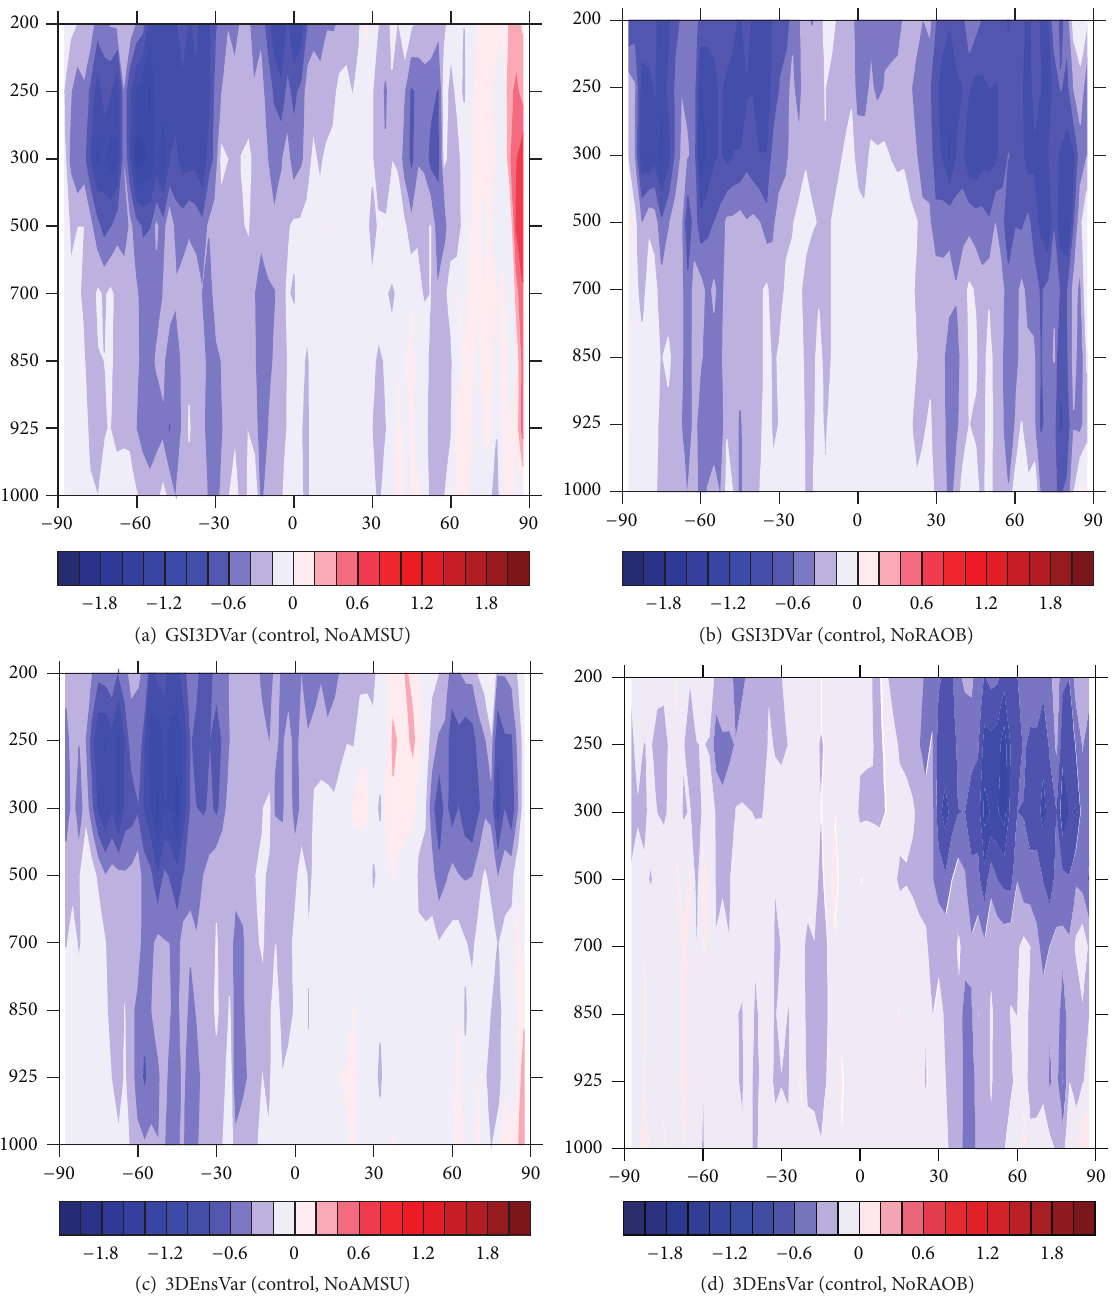
Figure 5: Zonally averaged root-mean-square error difference for 72 hr wind forecast (ms −1 ) between (a) GSI3DVar and GSI3DVar- NoAMSU, (b) GSI3DVar and GSI3DVar-NoRAOB, (c) 3DEnsVar and 3DEnsVar-NoAMSU, and (d) 3DEnsVar and 3DEnsVar-NoRAOB. Blue and red color indicate positive and negative data impact,